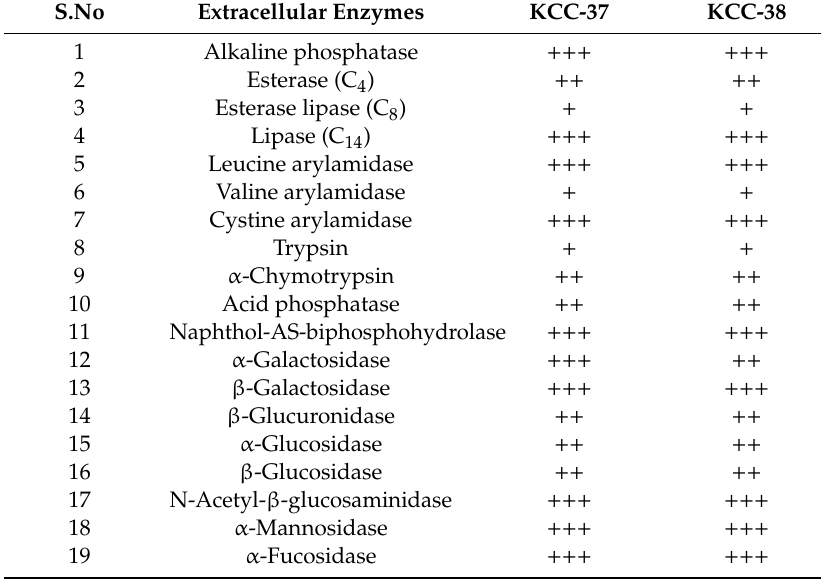
Table 2. Production of extracellular enzymes by L. plantarum KCC-37 and L. plantarum KCC-38. S.No Extracellular Enzymes KCC-37 KCC-38